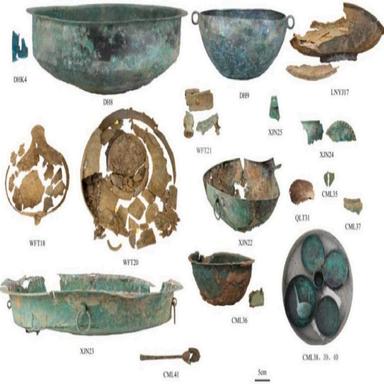
Some of the samples studied in the paper.